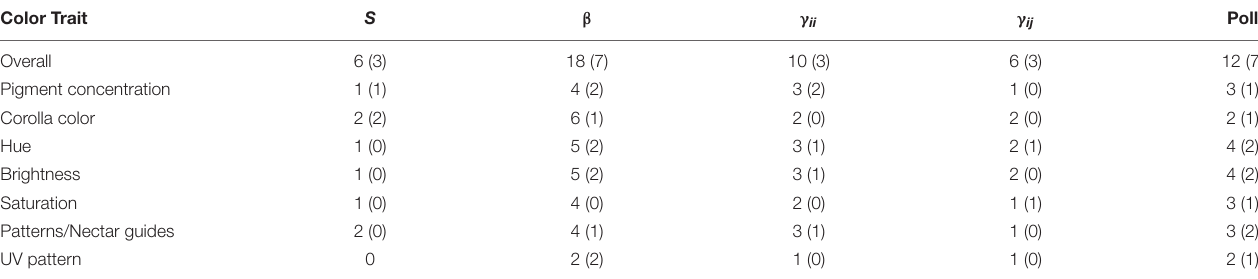
TABLE 1 | Summary of estimates of selection on continuous flower color variation in published studies and the proportion of significant estimates shown in brackets.